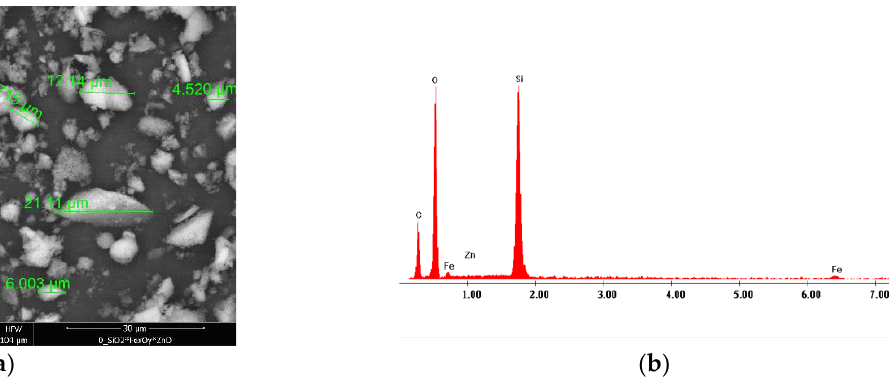
Figure 4. SEM picture recorded for prepared adsorbent material ( a ) and EDX spectra obtained for prepared adsorbent material ( b ).